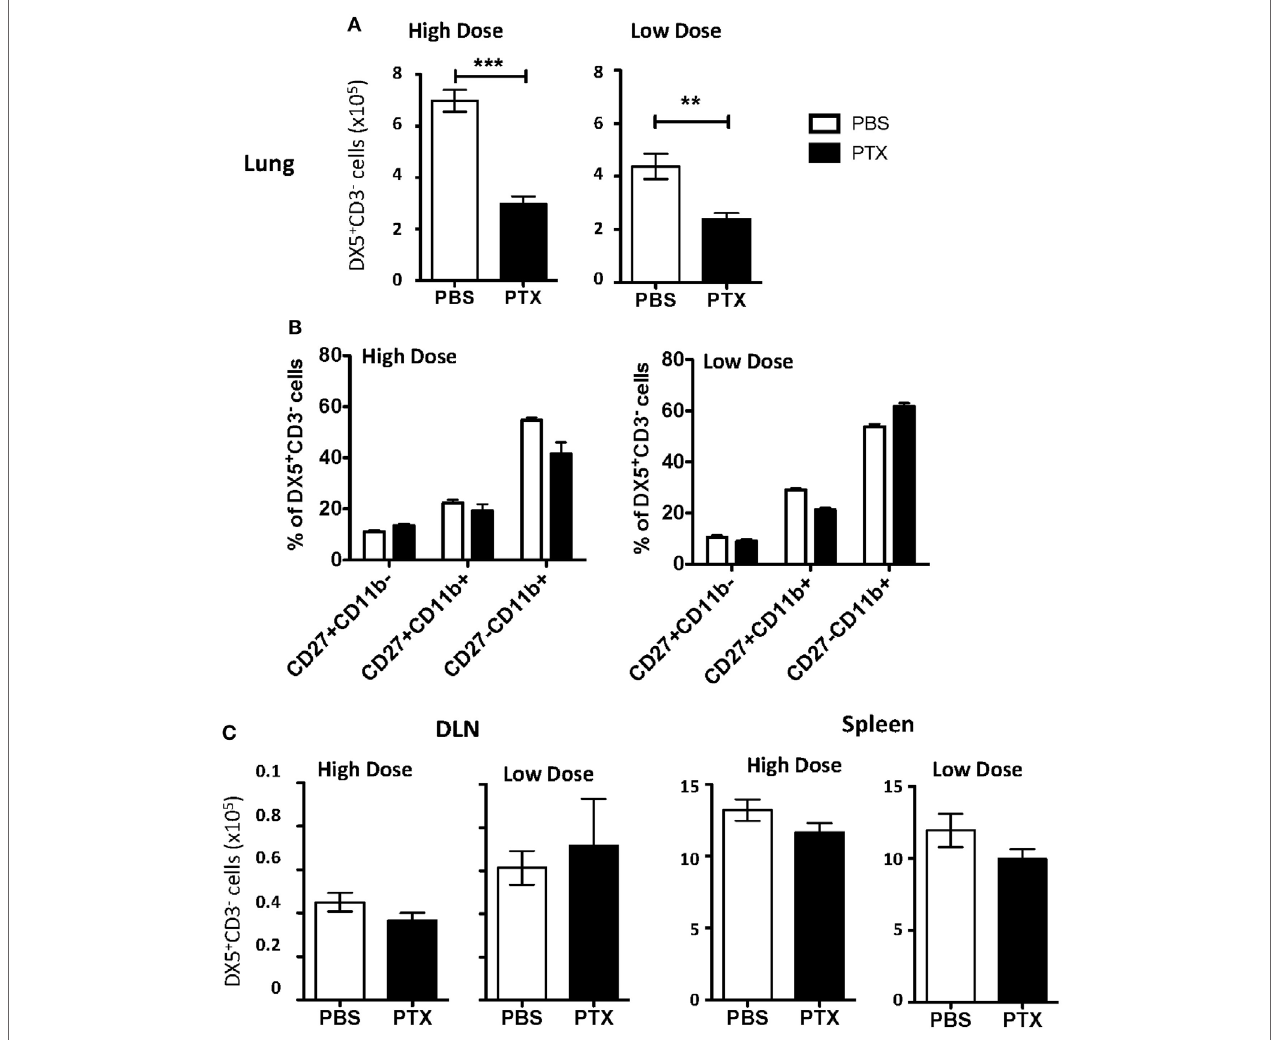
FigUre 3 | Blockade of chemokine receptor-mediated recruitment results in decreased natural killer (NK) cell accumulation in the influenza A virus (IAV)-infected lung. BALB/c mice were infected with either a high or a low dose of IAV and administered a 500 ng/200 μ l intraperitoneal injection of pertussis toxin (PT) or 200 µL phosphate buffered saline (PBS) on days 2, 3, 4, and 5 post infection (p.i.). On day 6 p.i., lungs (a) , draining lymph node (DLN) (per node) (c) , and spleens (c) were harvested from high-dose-infected mice or low-dose-infected mice, and the number and frequency of NK cells (DX5 + CD3 ε − gated) were determined by flow cytometry. (B) NK cells (DX5 + CD3 ε − gated) in the lung were further characterized by CD27 and CD11b expression to determine changes in functional NK subset distribution. Shown are the p -values comparing PT-treated mice to PBS-treated mice. ** p < 0.005, *** p < 0.001 (two-tailed unpaired Student’s t -test). Data are pooled from three high-dose experiments and two low-dose experiments, with five mice per